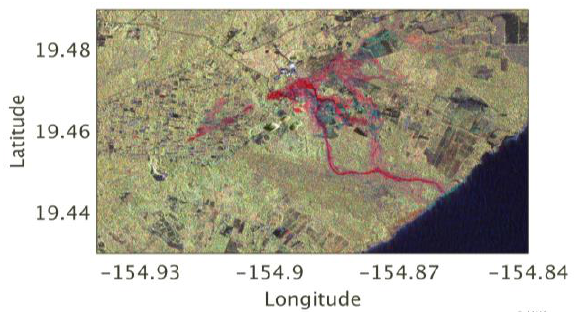
Figure 4. Color-composite image using Stripmap data acquired before (Feb. 27, 2018) and after (May 22, 2018) assigned as R, G, B=HV_bef, HV_aft, HH_aft. As the result, lava flows were shown in red